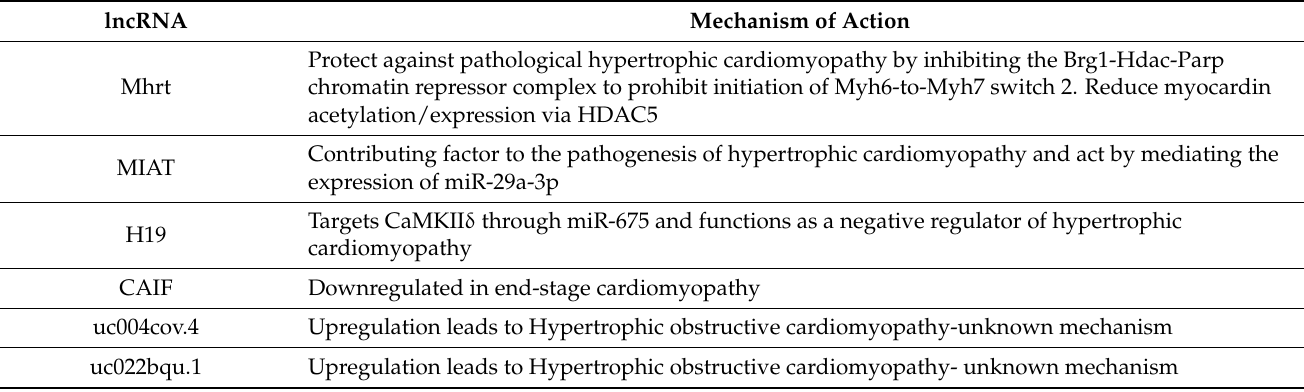
Table 4. LncRNAs involved in pathogenesis of hypertrophic